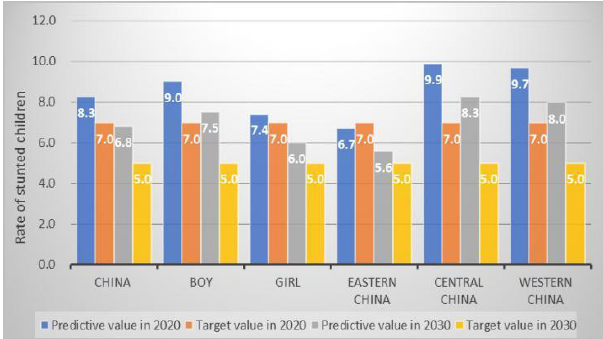
Figure 6. The estimated rate of Chinese stunting children and national nutrition target (%).